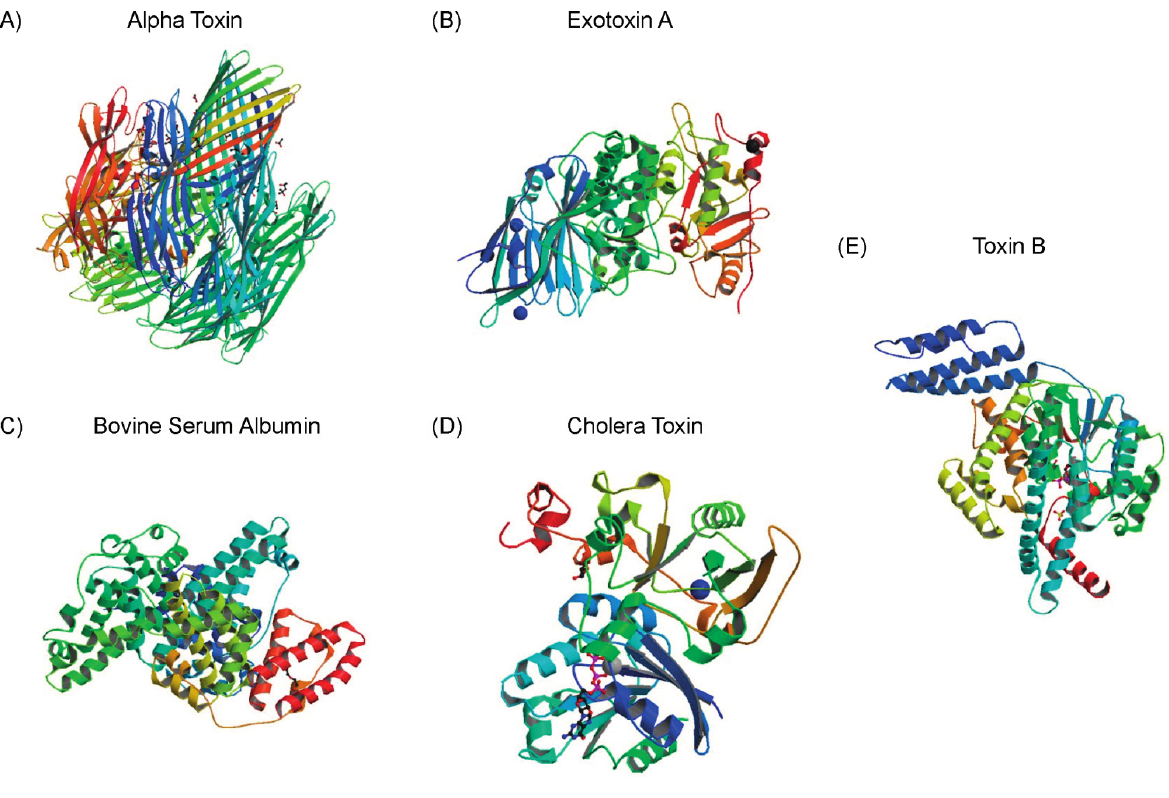
Figure 5. Structures of targets used in the SELEX scheme and cross binding assays. ( A ) Ribbon structure of the target of interest, alpha toxin (PDB 3ANZ, 33 kDa) [44]; ( B – E ) Ribbon structure of exotoxin A (PDB 1IKQ, 66 kDa) [45], bovine serum albumin (PDB 4F5S, 66.5 kDa) [46], cholera toxin (PDB 2A5D, 84 kDa) [47], and toxin B (PDB2BVM, 270 kDa) [48], used in negative rounds of selection and cross binding